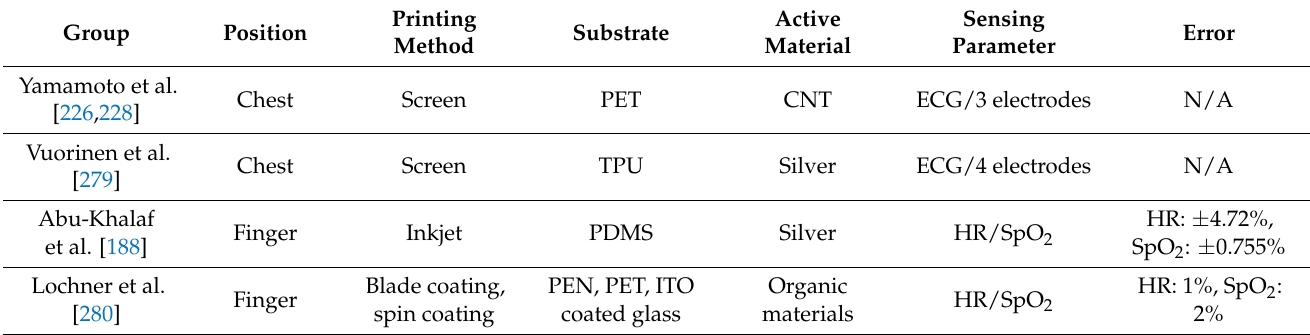
Table 4. A comparison between printed heart rate and SpO 2 sensors in the